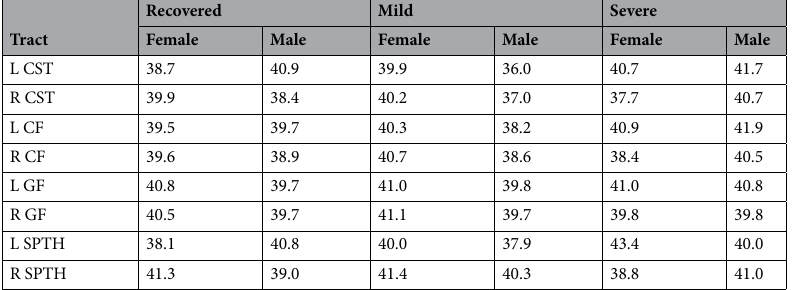
Table 7. Least square mean magnetization transfer ratio values from linear mixed model of each tract for clinical outcome groups by sex, including imputed data. White matter tracts above are the left and right corticospinal tracts (L and R CST), cuneate fasciculus (L and R CF), gracile fasciculus (L and R GF), and the combined spinothalamic and spinoreticular tracts (L and R SPTH).